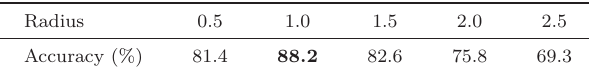
Table 2 Effect of radius on accuracy using ModelNet40